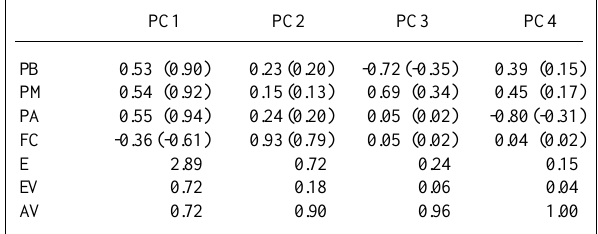
Table V - Principal components (PC), eigenvalues (E) and proportions of explained variances (EV) and accumulated variances (AV) for all data (non-regenerated and progeny of regenerated plants) of different Lycopersicon species.